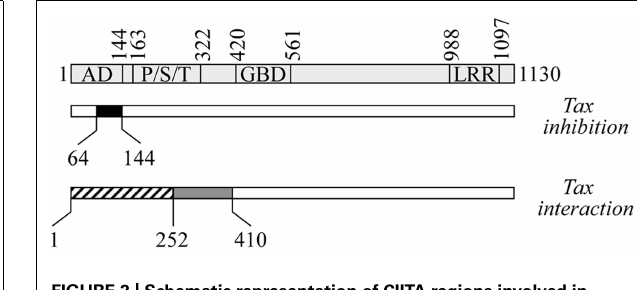
FIGURE 2 | Schematic representation of CIITA regions involved in the suppression ofTax function and in CIITA-Tax association. At the top is a diagram of CIITA with its domains: AD, activation domain; P/S/T, proline/serine/threonine-rich domain; GBD, GTP-binding domain; and LRR, leucine-rich repeats.The black box represents the minimal domain from positions 64–144 that is necessary to block the transcription function of Tax ( Tax-inhibition , middle). Hatched (positions 1–252) and gray (positions 253–410) boxes represent the two regions of CIITA interacting withTax ( Tax interaction ,